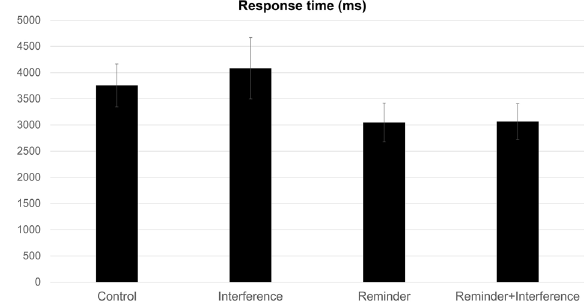
Fig. 3 Percent ‘ Remember ’ responses for each condition of Experiment 1. Brackets represent 95% con fi dence